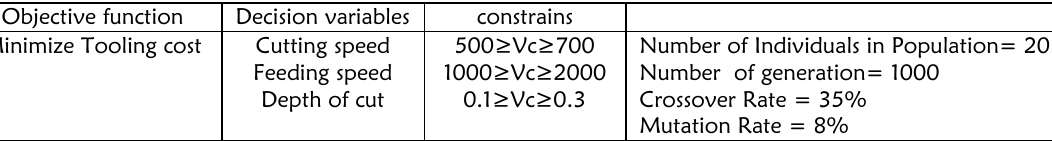
Table 4: GA objectives, decision variables, constrains and parameters.